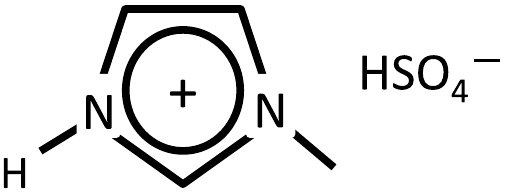
Figure 5. Structural formula of 1-methylimidazolium hydrogen sulfate ([MIM]HSO 4